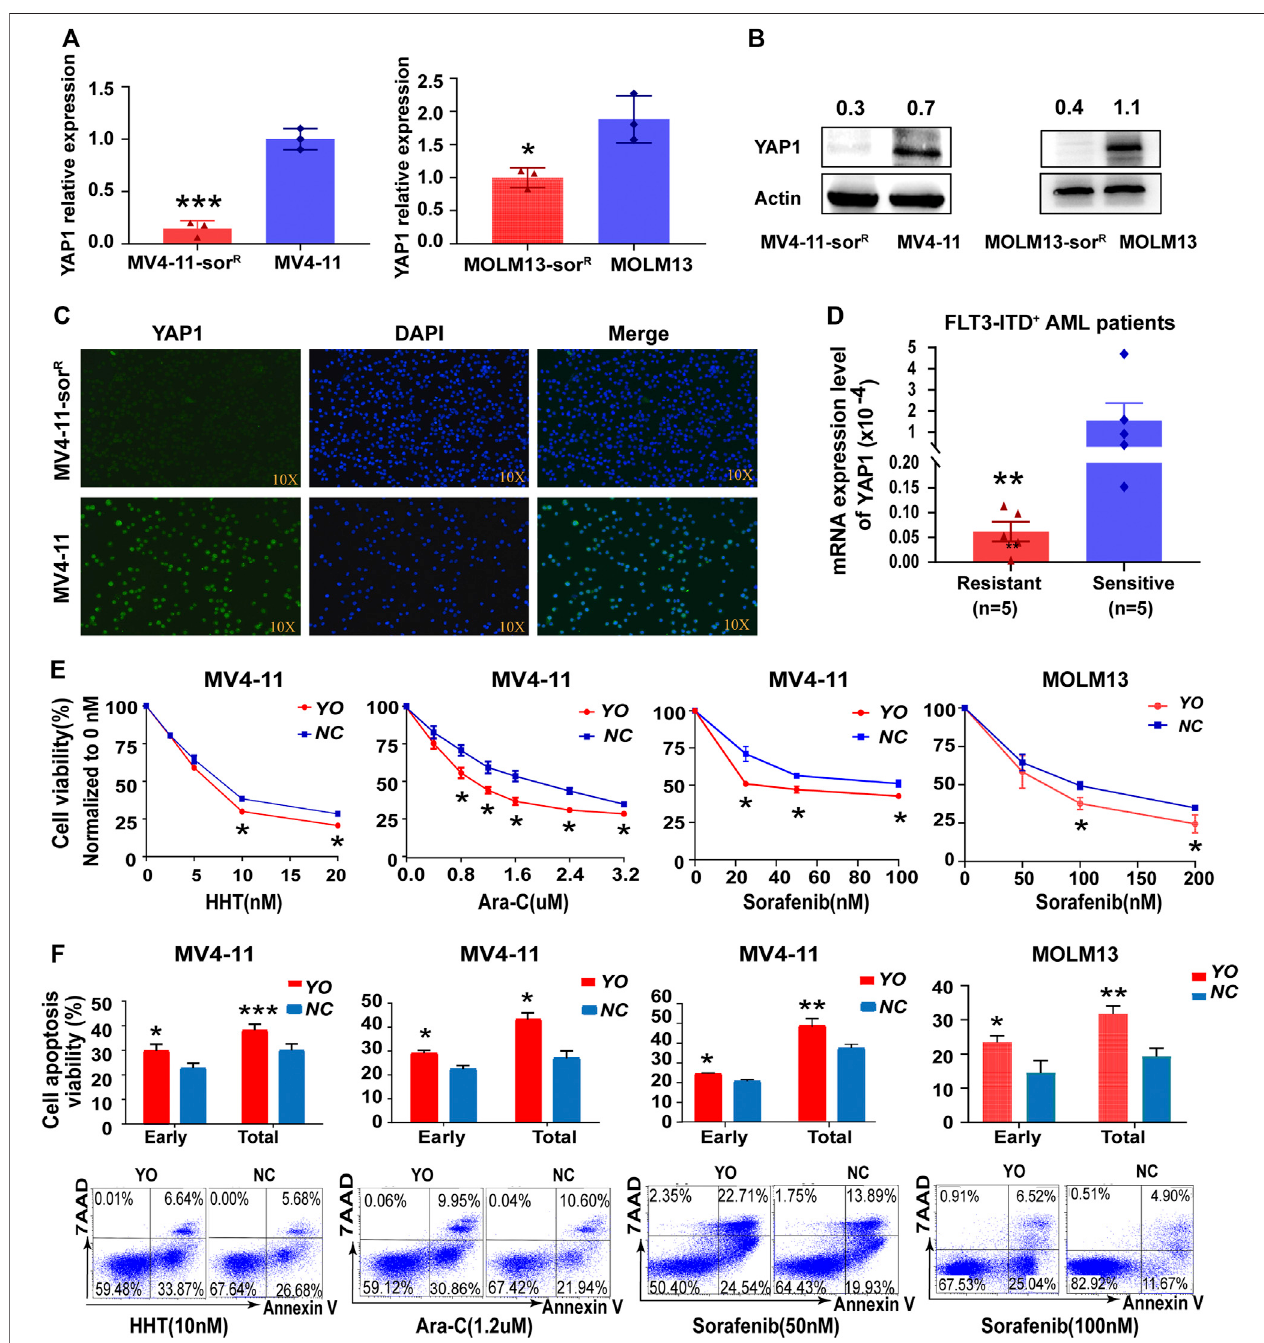
FIGURE2| InactivationofYAP1promotesdrugresistancetochemo-andtargetedtherapyinFLT3-ITD + AMLcells. (A – C) YAP1expressionwasmeasuredbyRT- qPCR,Westernblot,andimmuno fl uorescenceinsorafenib-resistantcellsandtheparentalcellsofMV4-11andMOLM13. (D) YAP1expressionwasanalyzedinresistant FLT3-ITD + AML patients ( n = 5, red) and sensitive FLT3-ITD + AML patients ( n = 5, blue). (E) Cell growth inhibition of YO and NC cells was calculated after 48 h of treatment with serial dilutions of homoharringtonine (HHT), cytarabine (Ara-C), and sorafenib. (F) YO and NC cells were treated with HHT (10 nM), Ara-C (1.2 μ M), and sorafenib (50 nM or 100 nM) for 24 h to measure apoptosis by fl ow cytometry. Data are shown as mean ± SD; * p < 0.05; ** p < 0.01; *** p < 0.001.